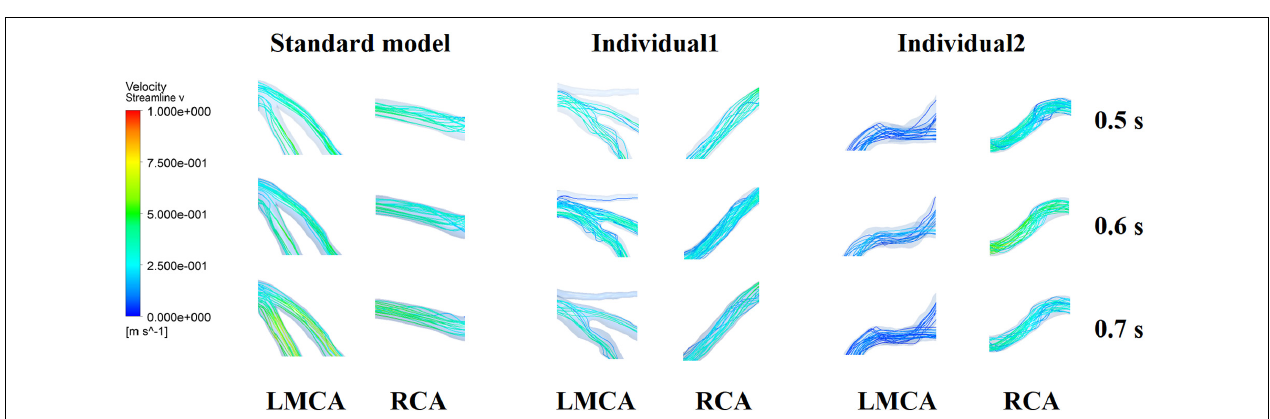
FIGURE 11 | Velocity streamlines of three models in the counterpulsation state.